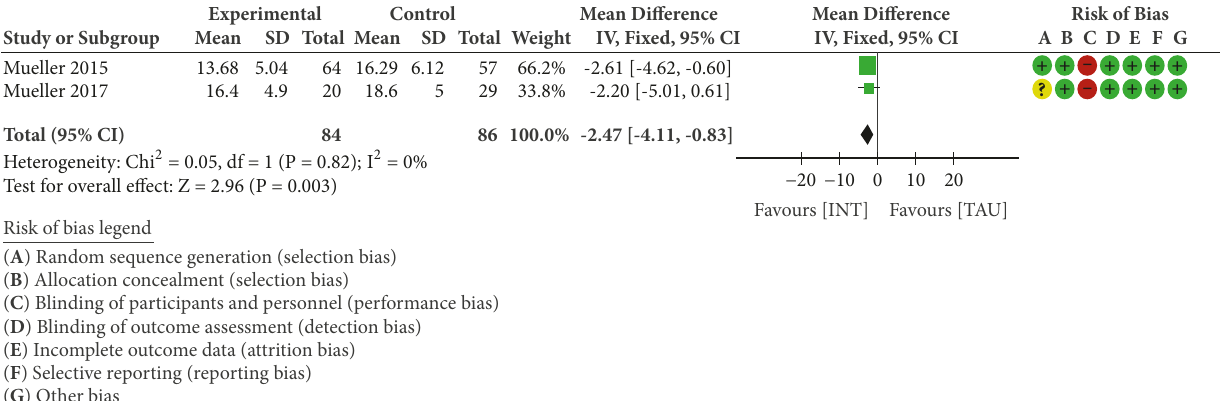
Figure 3(a)) and at 9-12-month follow-up (MD -2.47, 95%CI -4.11 to -0.83, and P=0.003; Figure 3(b)), with no evidence of statistical heterogeneity